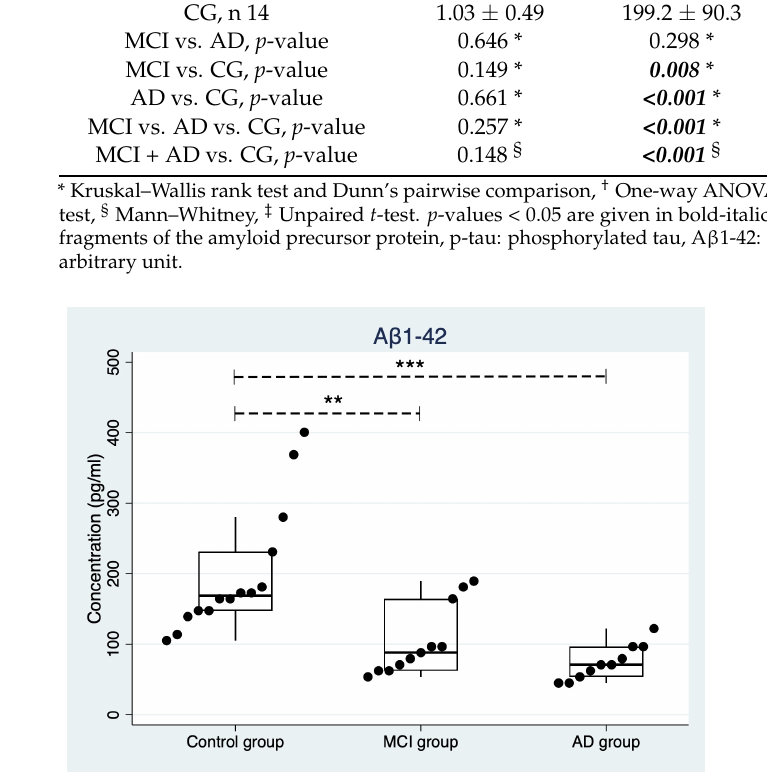
Figure 2. Strip plot showing the concentration of A β 1-42 in the control group, in prodromal AD (MCI), and in mild-to-moderate AD. Boxes specify medians and quartiles, vertical spikes represent the largest or smallest value within the IQR of the upper or lower quartile. Two asterisks indicate p ≤ 0.01, three asterisks indicate p ≤ 0.001. MCI: mild cognitive impairment due to Alzheimer’s disease, AD: Alz- heimer’s disease.